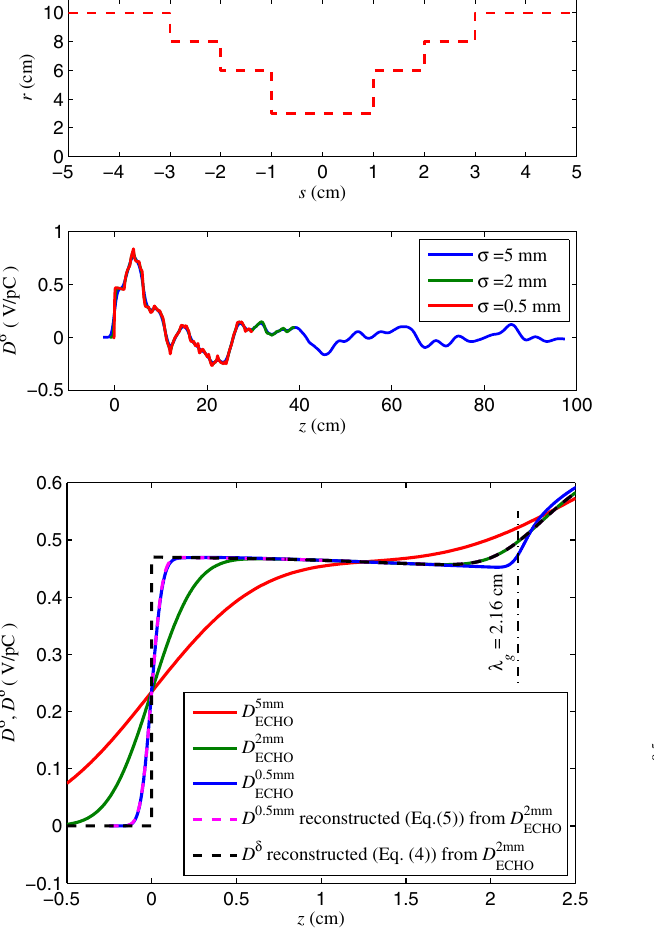
FIG. 4. (top) Three-step collimator geometry; (middle) long- range functions D (cid:1) ð z Þ calculated with ECHO ; (bottom) directly calculated (solid) and reconstructed (dash) functions D (cid:1) ð z Þ and D (cid:4) ð z Þ